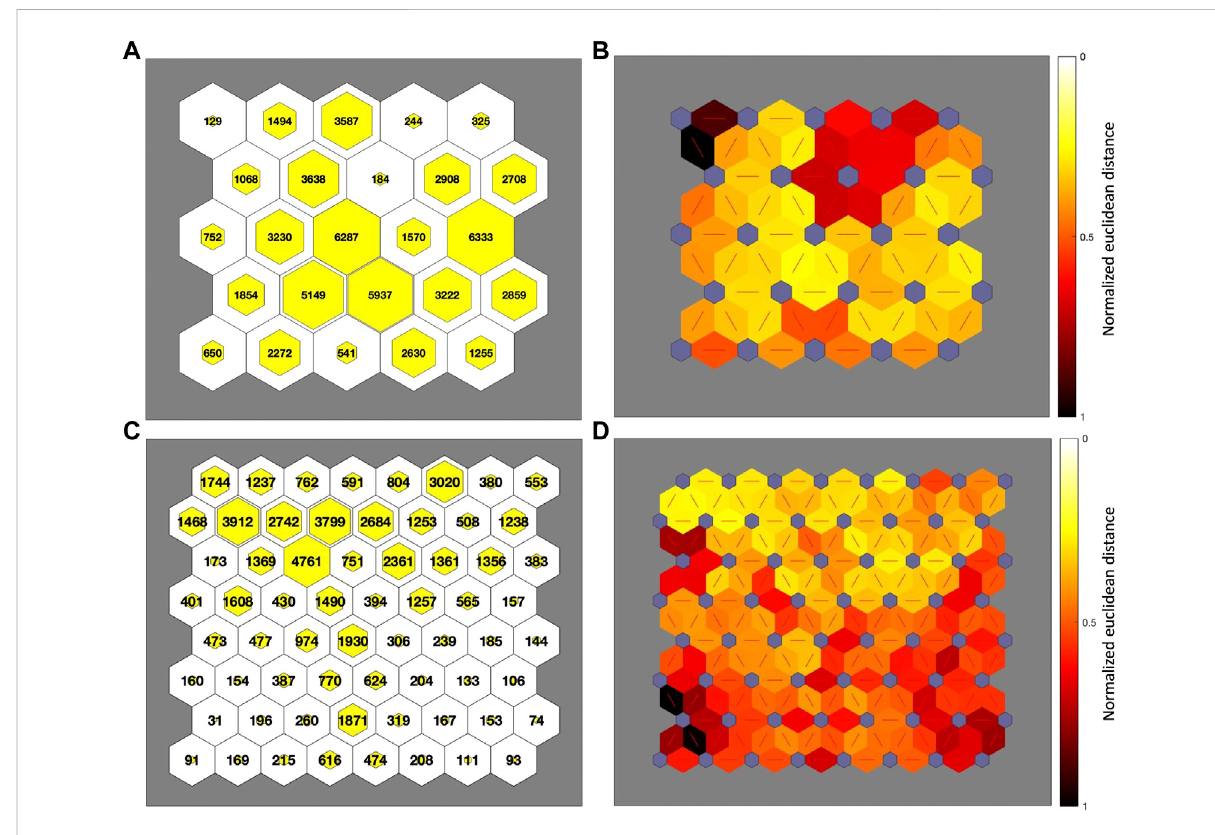
FIGURE 6 (A,C) HitsofVLP-dataonthe5×5-SOMmap (A) ,andhitsofULP-dataonthe8×8-SOMmap (C) .Eachhexagonrepresentsonenodeonthemap; the size of the inner yellow hexagon shows how many events fall in each node of the map. Refer to Figure 7 for the order of nodes. (B,D) The normalizedeuclideandistanceamong “ nodes ” prototypesofthetopographicmapisshown.Thenormalizeddistancebetweentheadjacentnodesis presented with different colorings between the adjacent nodes: Dark colors (dark red) represent large distances, and light colors (light yellow) correspond to small distances among prototypes of